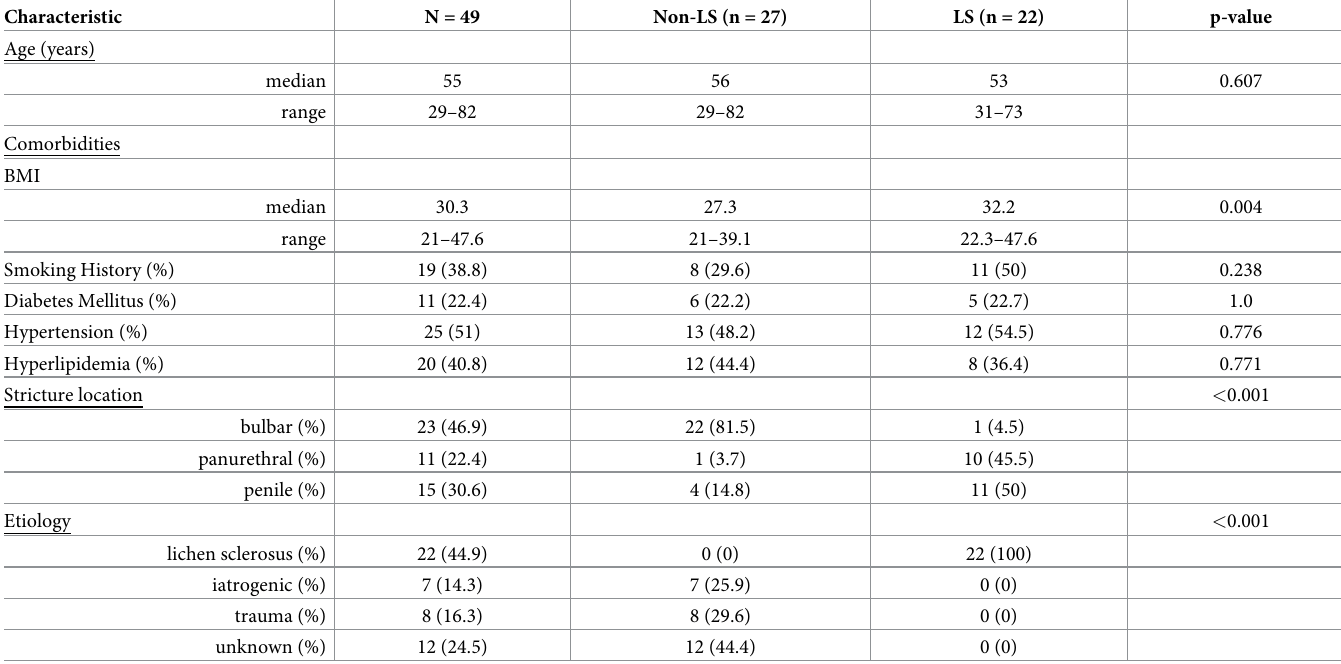
Table 1. Patient demographics for all of the samples included in this